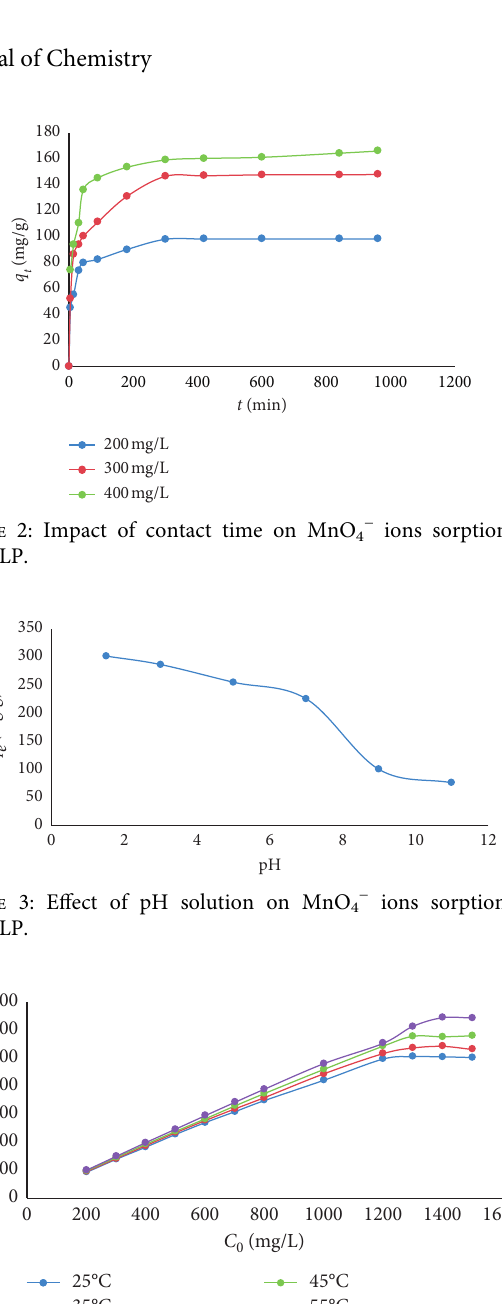
− concentration on 4